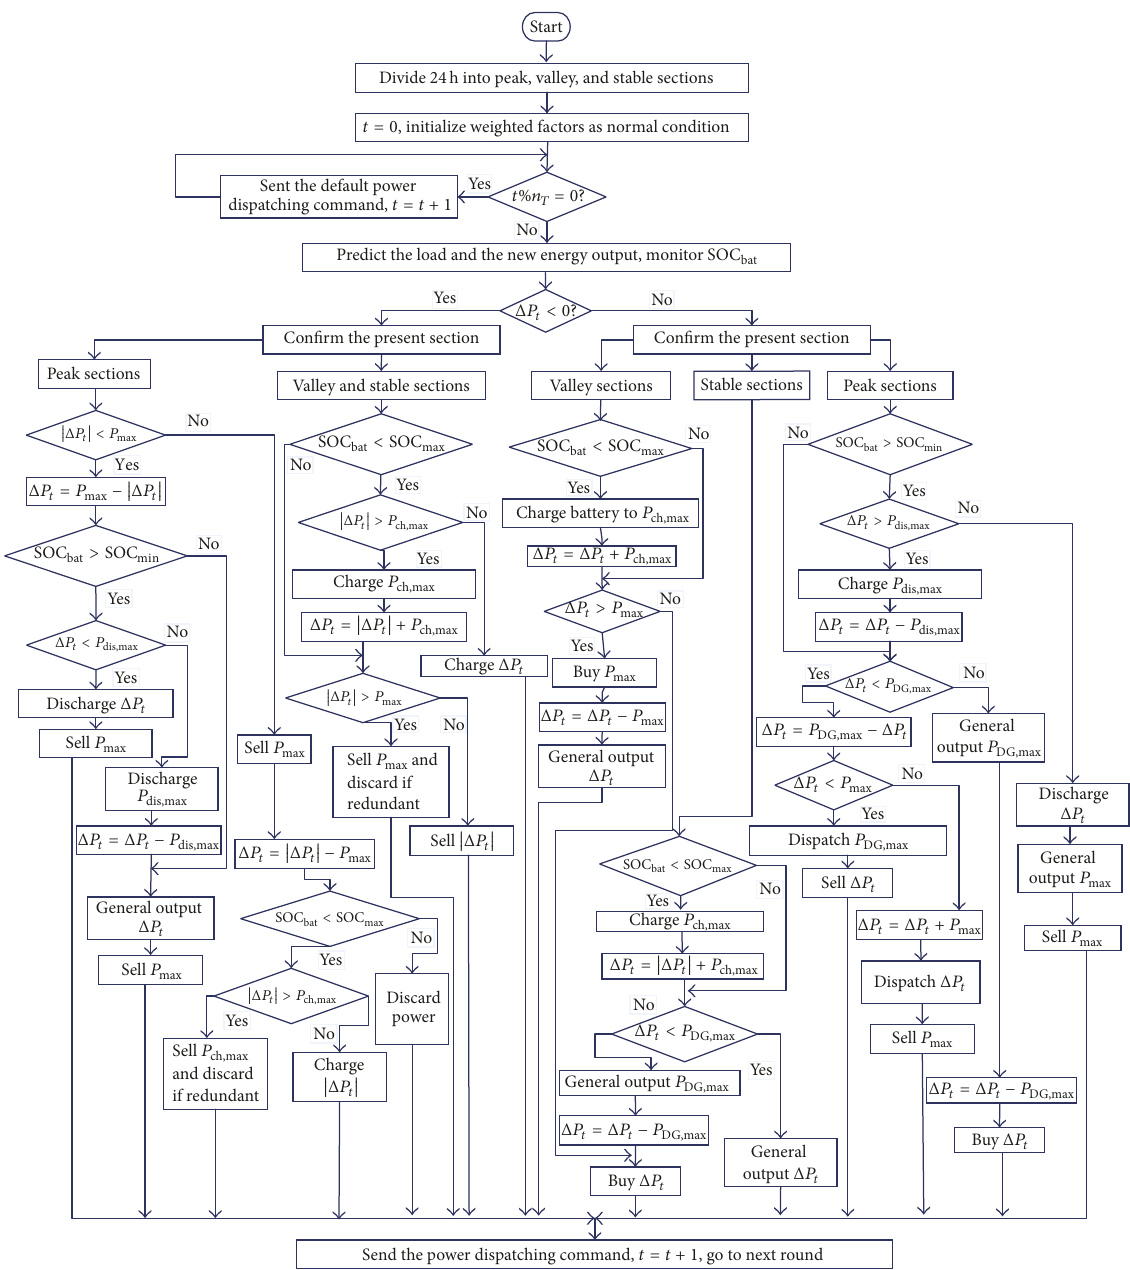
Figure 1: The general flow chart of the scheme for normal